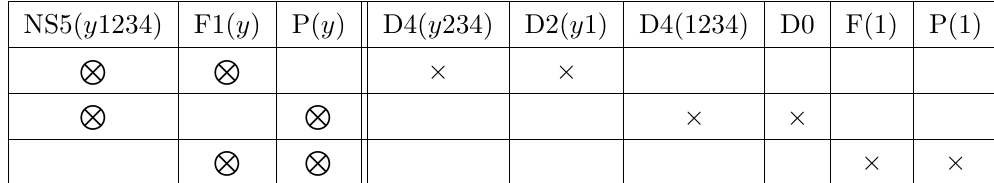
Table 1 . Each line describes a two-charge bound state whose charges are two of the three charges of the NS5-F1-P brane systems (denoted by N ). Each bound state contains two more dipole charges, denoted by × . We attempt to construct a three-charge bound state with NS5-F1-P and all six dipole